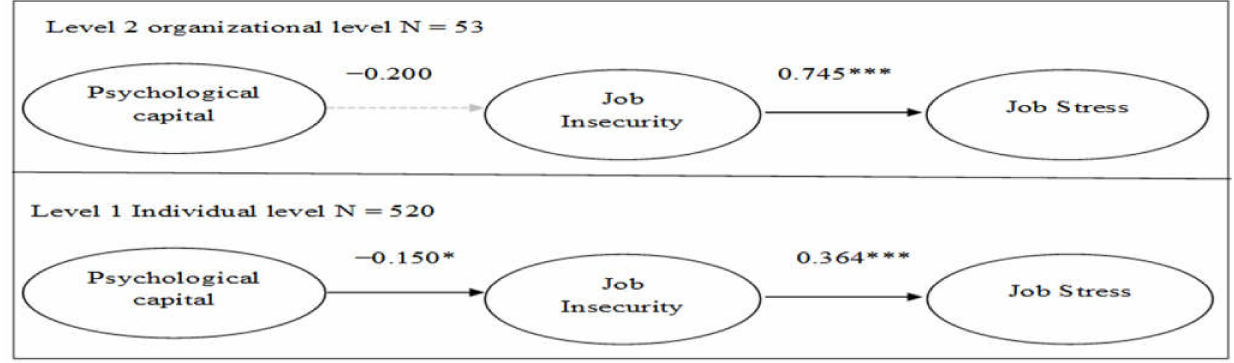
Figure 1. Multilevel structural equation modeling (MSEM) results. Note: * p < 0.05. ** p < 0.01. *** p < 0.001. Dashed lines represent non-significant